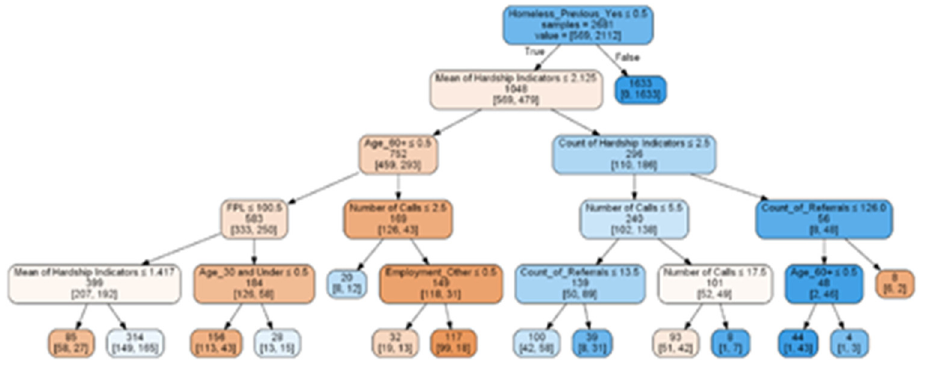
Figure 2. Decision-tree analysis results.